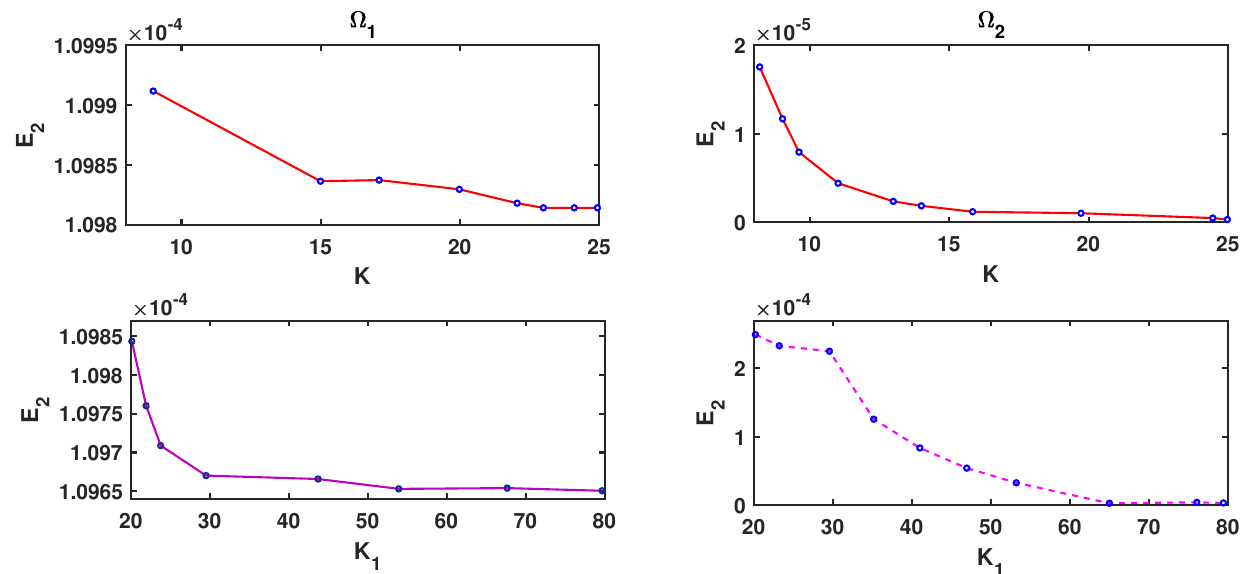
Figure 5. E 2 –errors and convergence for Example 2 in different domains at T = 0.5, where τ = 0.1,